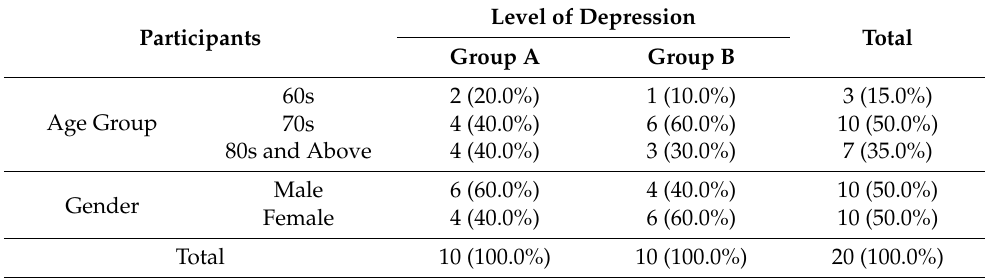
Table 4. Classification of investigation targets for EEG.